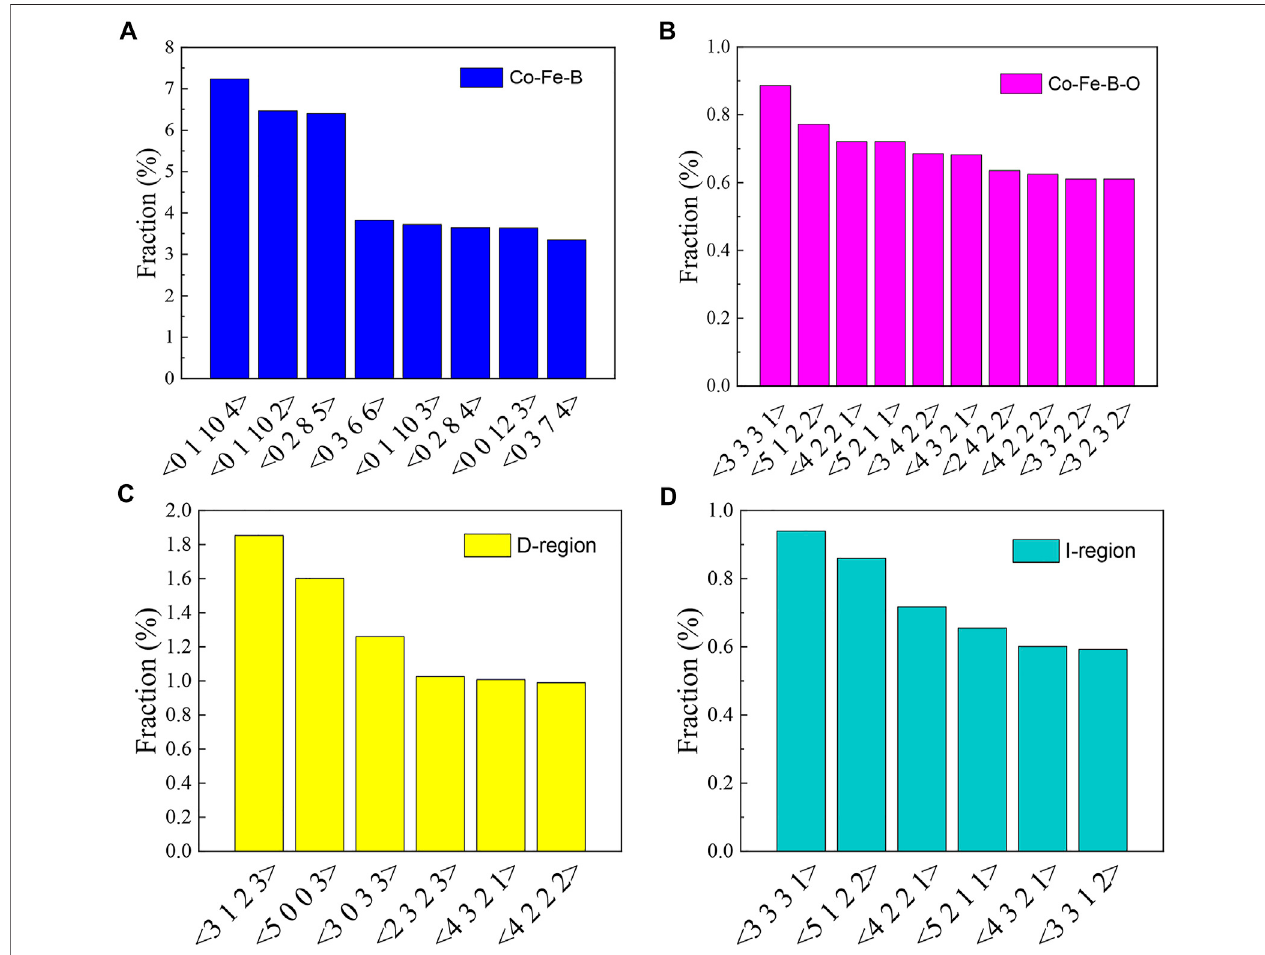
FIGURE 4| Distributions oftypical Voronoi polyhedral indices ofFe-centered clusters in the (A) Co-Fe-B, (B) Co-Fe-B-O systems, (C) D-region and (D) I-region of the Co-Fe-B-O system.